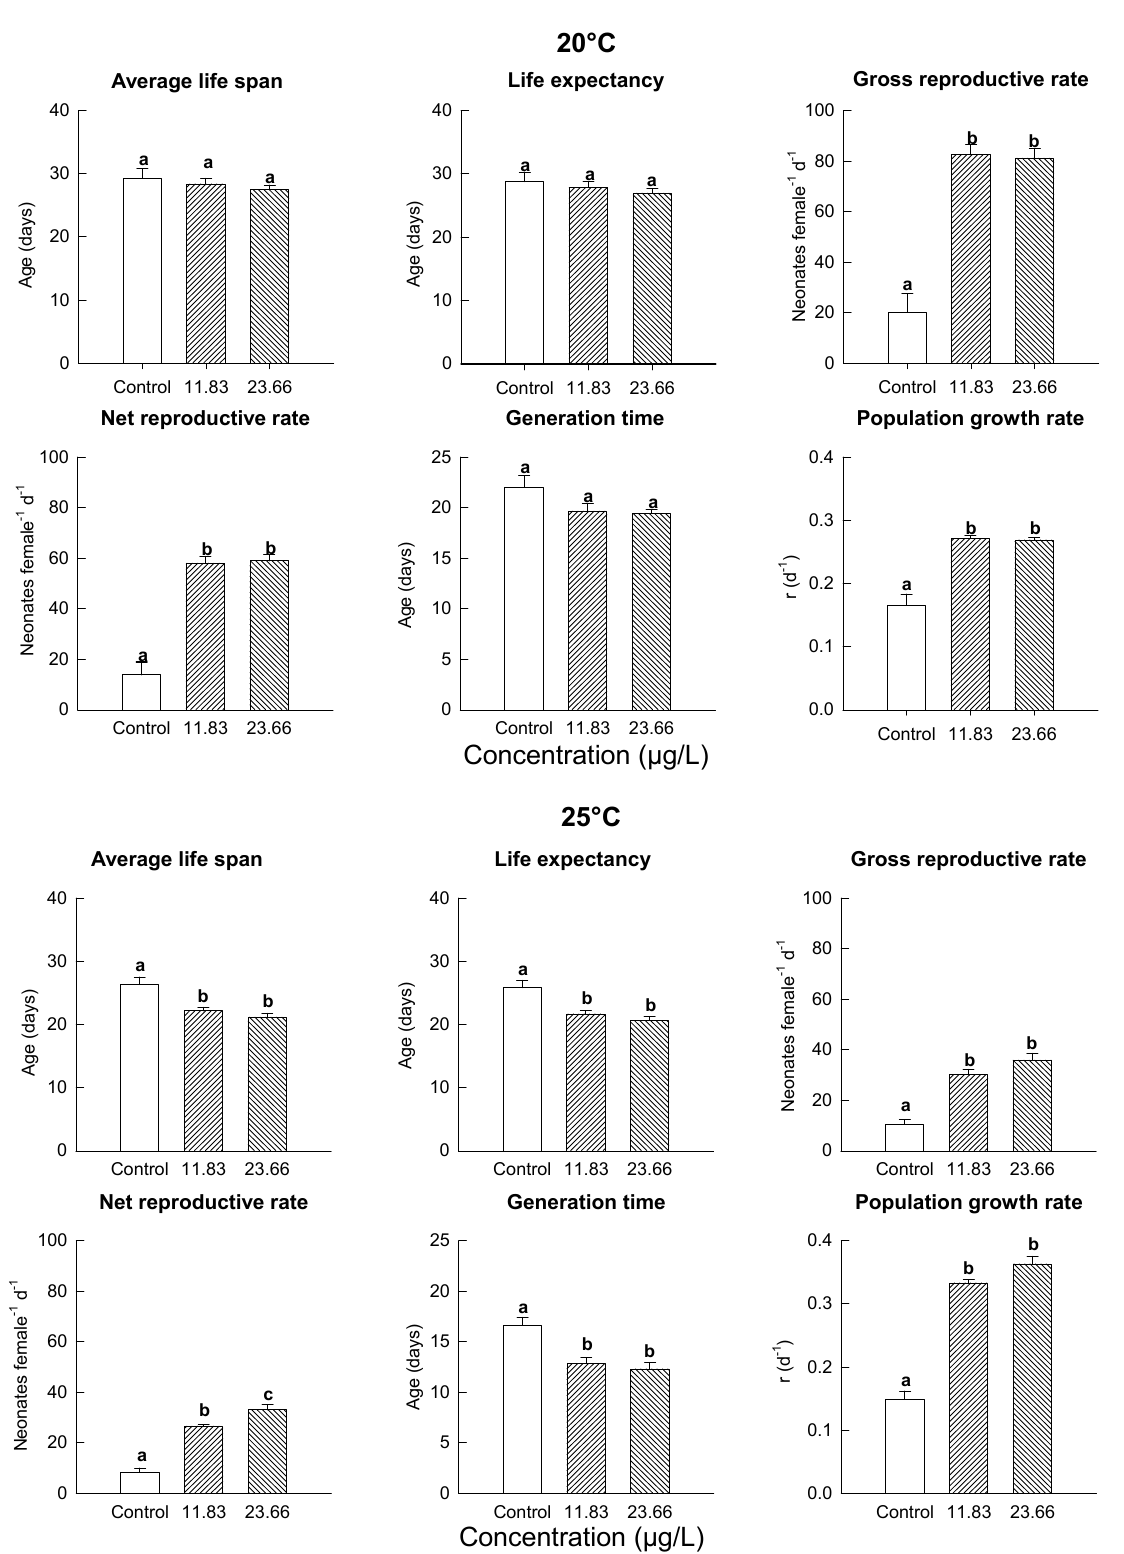
Figure 5. Life history variables of Daphnia pulex exposed to cyanobacterial extracts from blooms of Woronichinia (September) at 20 °C and 25 °C. Shown are the means ± SE based on four replicate recordings. Data bars carrying different alphabets for a given variable are significantly different (p < 0.05)